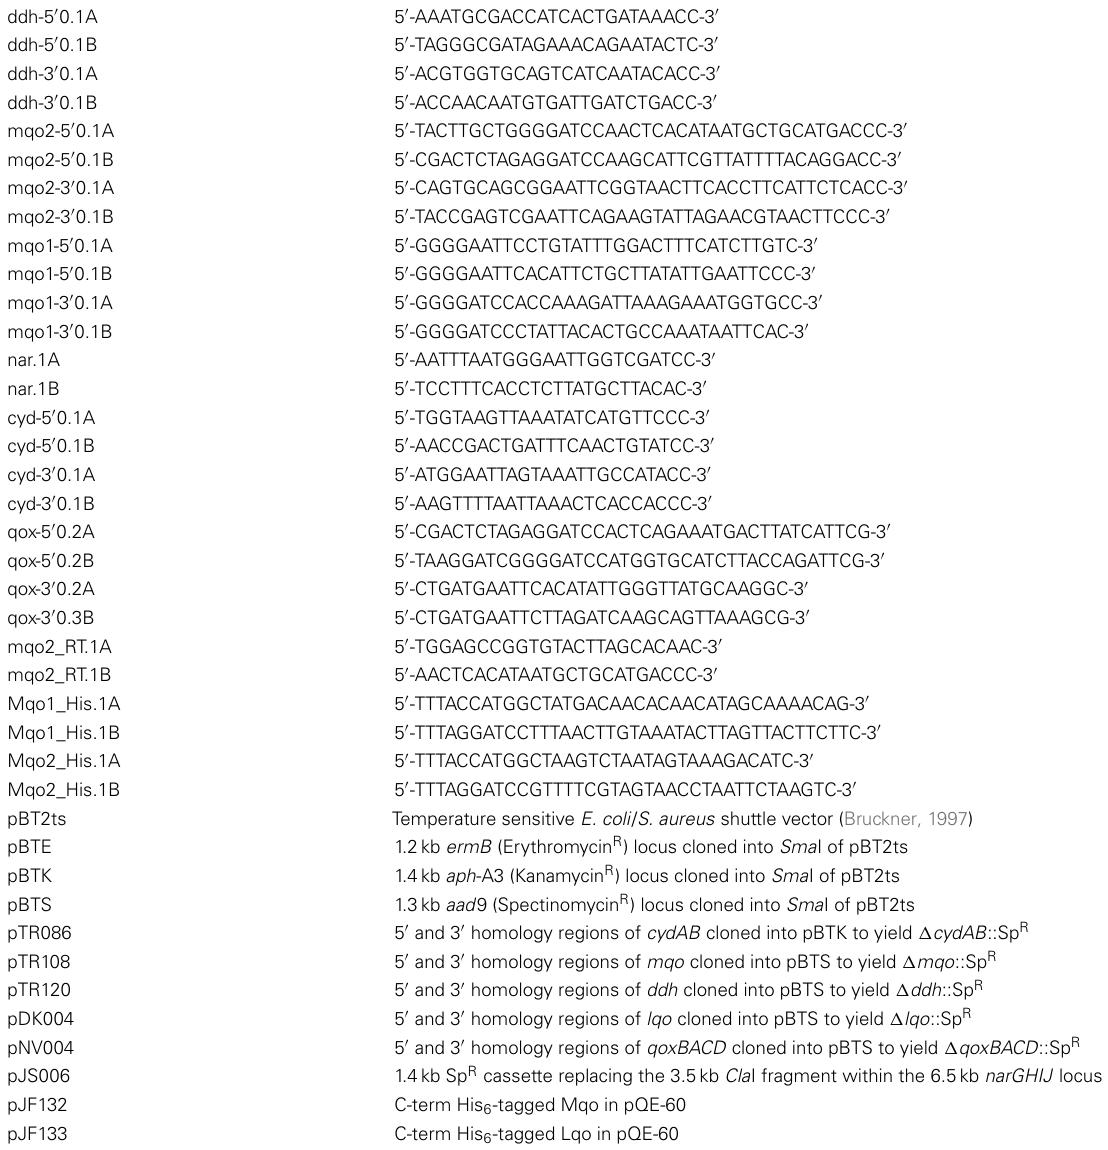
TableA2 | Primers/plasmids used in this